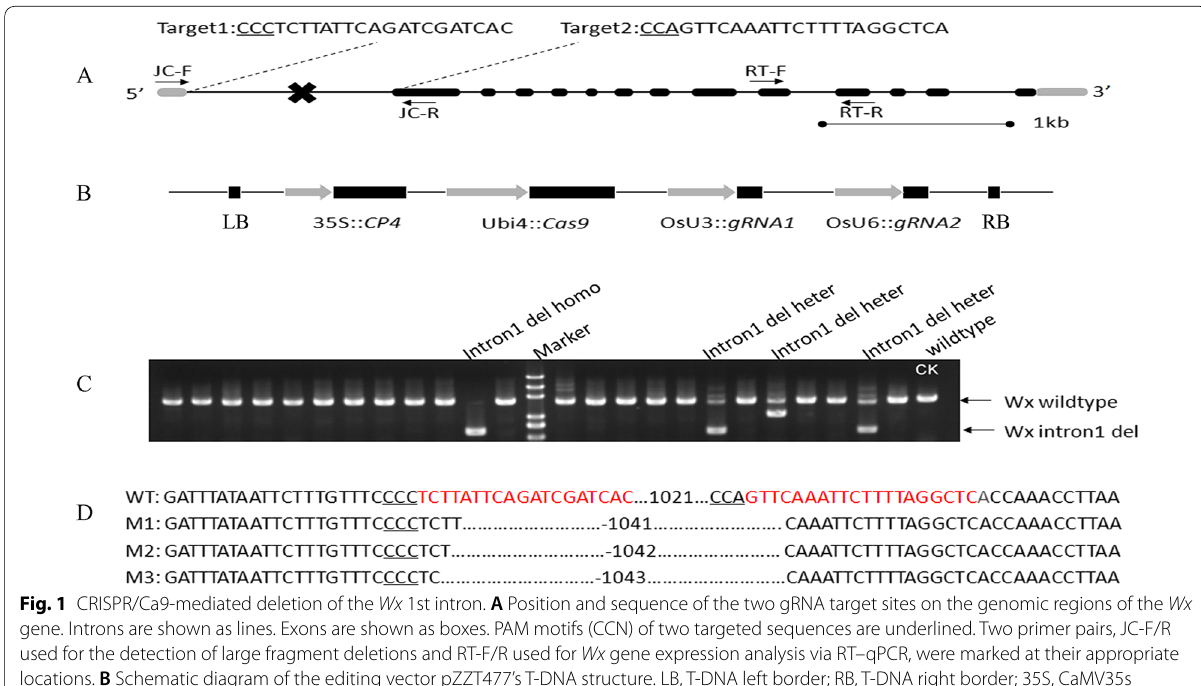
Fig. 1 CRISPR/Ca9-mediated deletion of the Wx 1st intron. A Position and sequence of the two gRNA target sites on the genomic regions of the Wx gene. Introns are shown as lines. Exons are shown as boxes. PAM motifs (CCN) of two targeted sequences are underlined. Two primer pairs, JC-F/R used for the detection of large fragment deletions and RT-F/R used for Wx gene expression analysis via RT–qPCR, were marked at their appropriate locations. B Schematic diagram of the editing vector pZZT477’s T-DNA structure. LB, T-DNA left border; RB, T-DNA right border; 35S, CaMV35s promoter; CP4, Agrobacterium tumefaciens strain CP4 EPSP (5-enolpyruvylshikimate-3-phosphate synthase) gene; Ubi4, sugarcane ubiquitin 4 gene promoter; Cas9, CRISPR/Cas9 gene with codon optimized for expression in rice; U3, U6, rice U3 and U6 snRNA promoter. C Detection of mutations in the first intron of the Wx gene via PCR assay in the T0 generation. D Sequencing results of the first intron-deleted mutant lines. The PAM motifs are underlined, target sequences are highlighted in red, and dotted lines indicate deletions. The WT indicates the wild type, and M1, M2, and M3 are different homozygous lines in the T1 generation